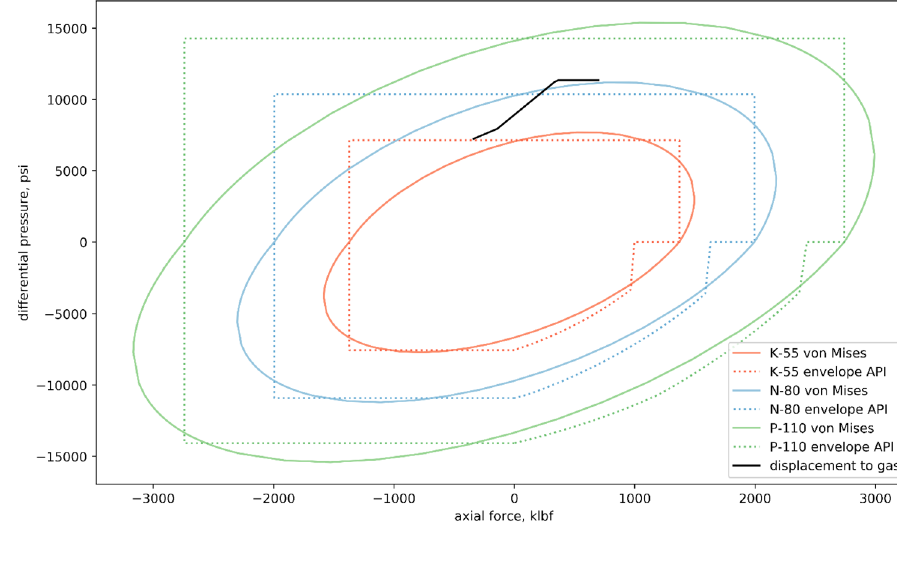
Fig. 14 Probabilities of exceed- ing SLS along the depth of the well for the adopted